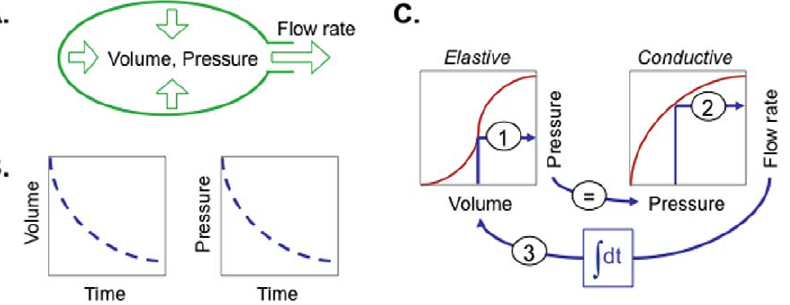
Figure 3. Simple example of a dynamical model. (A) Two-element ‘‘Windkessel’’ model for fluid flowing from an elastic vessel such as a balloon, lung, or blood vessel. (B) Positive pressure in the vessel due to tension in the vessel wall drives fluid from the vessel which decreases both the volume and pressure as a function of time. (C) An iterative algorithm (blue arrows) can simulate the time course of changing volume, pressure, and flow rate in terms of a temporal integral dependency, an elastive dependency (the reciprocal of a capacitive dependency), and a conductive dependency (the reciprocal of a resistive dependency).